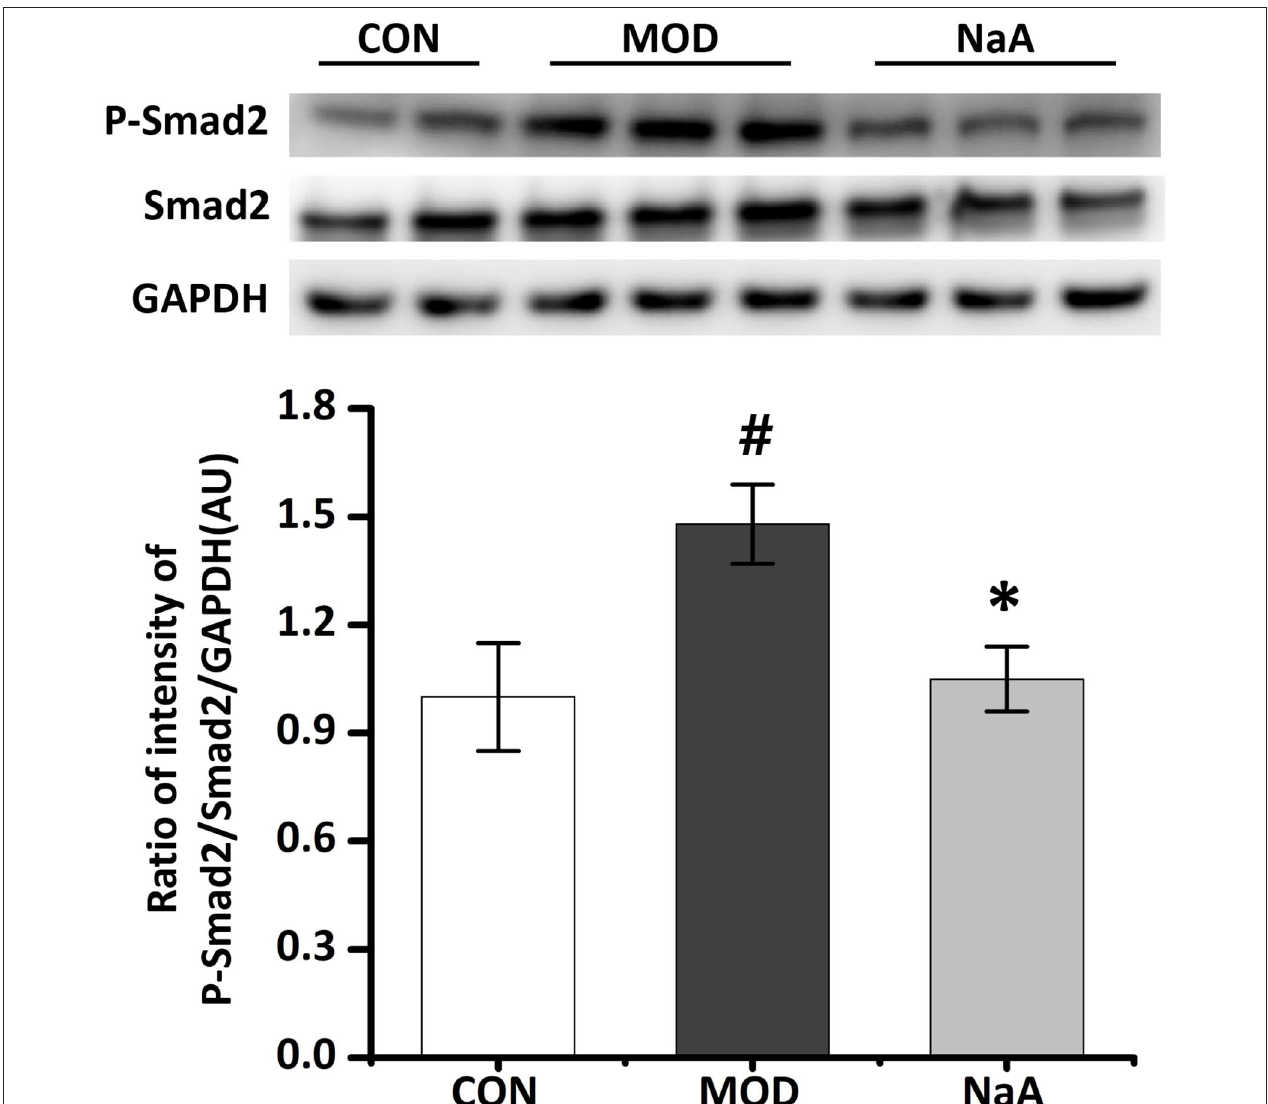
FIGURE 2 | NaA inhibited TGF- β 1 induced HSCs activation in LX2 cells. LX2 cells were treated with or without 2.5ng/ml TGF- β 1 and 1mM of NaA for 48h. Western blot was used to evaluate the phosphorylation of Smad2. LX2 cells were treated as detailed in the section Materials and Methods. For all bar graphs, data are the mean ± SD, # p < 0.05, as compared with CON, and * p < 0.05, as compared with MOD. The significant difference was assessed using the one-way ANOVA followed by LSD post-tests. Control group (CON), group model cell treated with a TGF- β 1 (MOD), sodium acetate (NaA), arbitrary unit